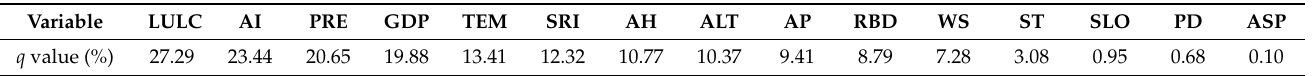
Table 3. Results of factor detector affecting vegetation distribution in Mu Us Sandy Land.